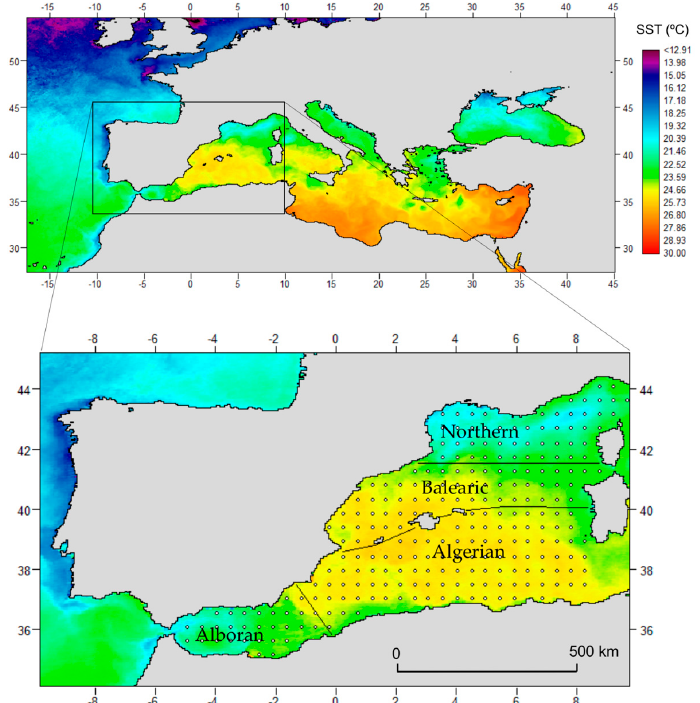
Figure 1. Example image of Sea Surface Temperature (SST) of the Mediterranean Sea used in the study. It corresponds to August 2000 from the Terra-MODerate-resolution Imaging Spectroradiometer (MODIS) satellite. The zoom shows the study area (WMed) and the four sub-basins with the grid points used to calculate the average values.